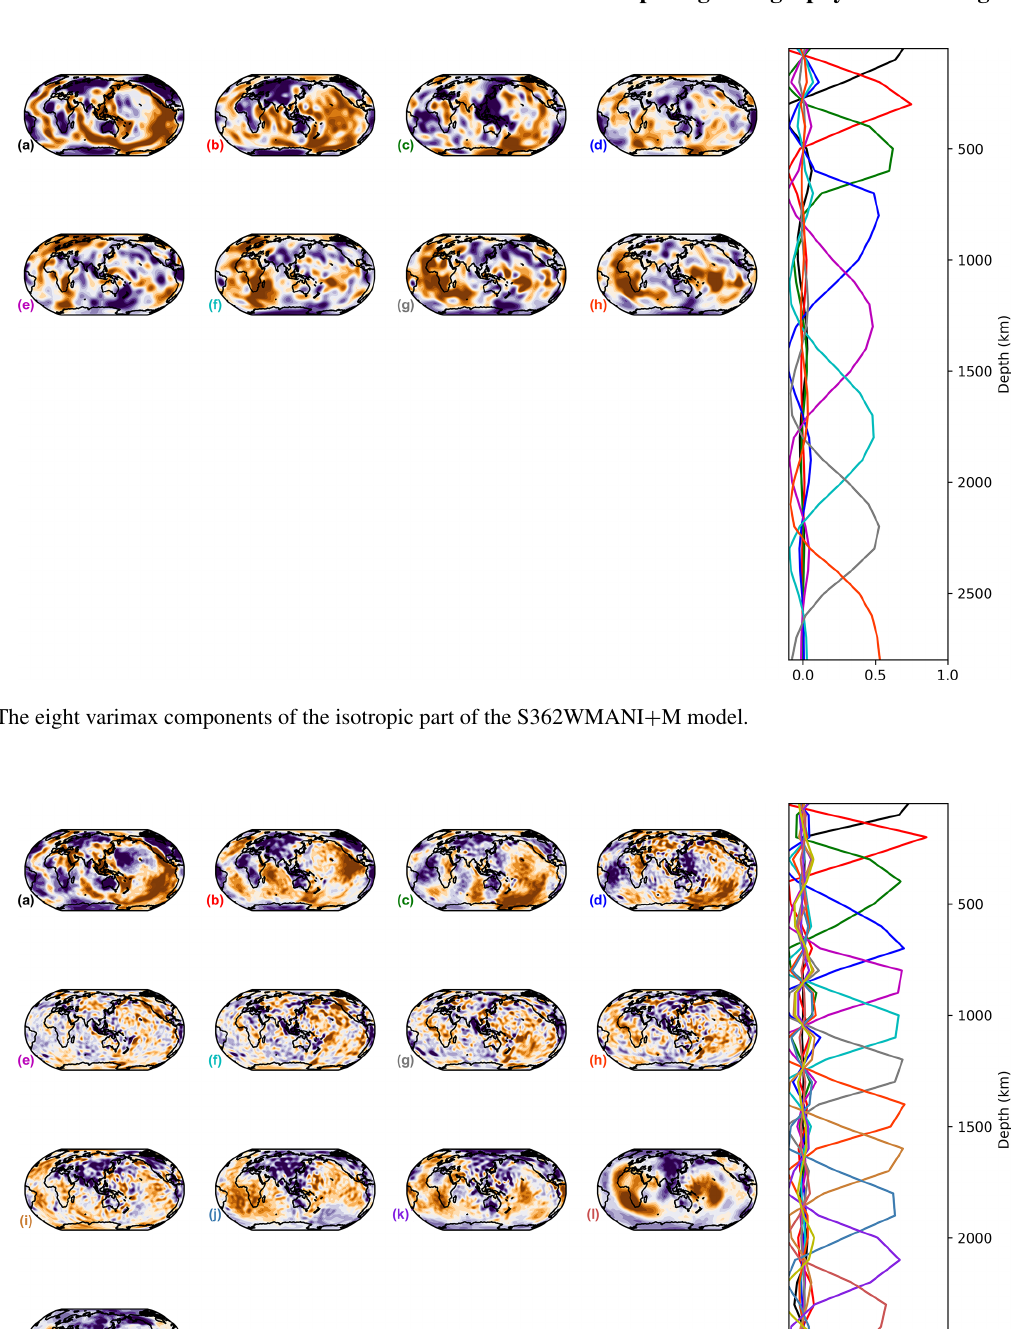
Solid Earth, 12, 1601–1634,